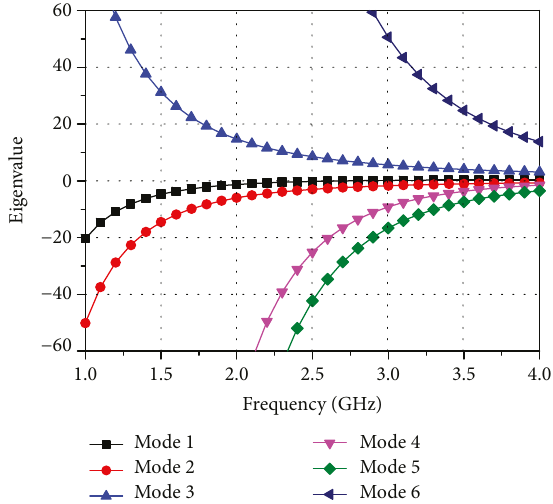
Figure 1: Eigenvalues of the fi rst six modes for the 50mm × 30 mm rectangular metal